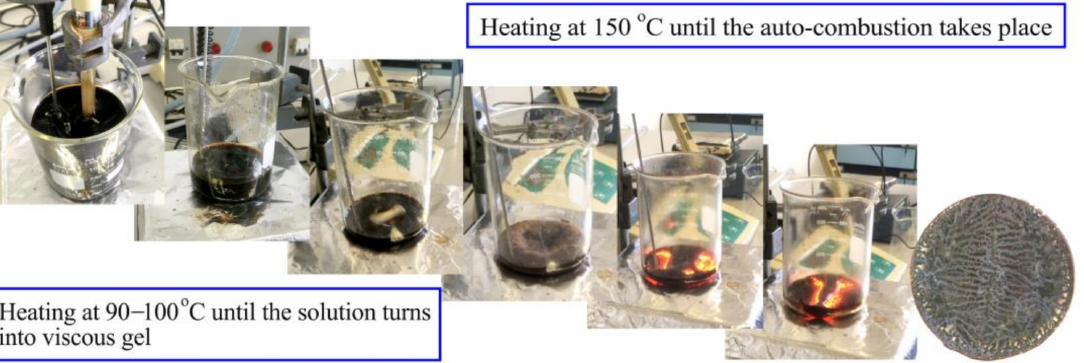
Figure 1. Stepwise photographs of sol-gel auto-combustion synthesis of BaM